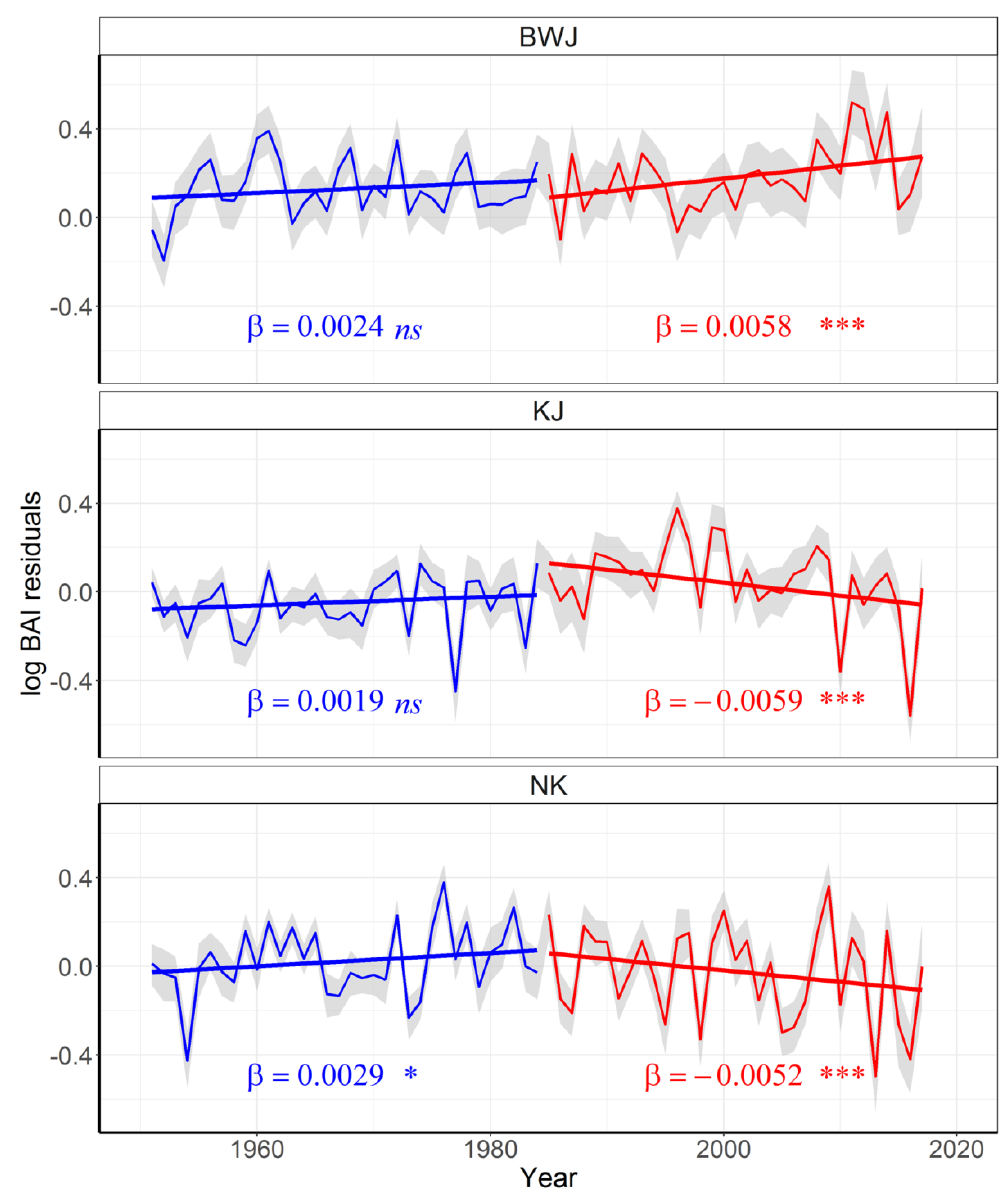
Figure 7. Long-term trends of tree growth (log BAI residuals) of P. latteri during the periods 1951–1984 (blue lines) and 1985–2017 (red lines) at three study sites (BWJ, KJ, NK) in Thailand. Shade area represents 95% confidence intervals. Lines represent effects of fixed effect “Year” (slope “β”) and their significance as shown in Table 2.